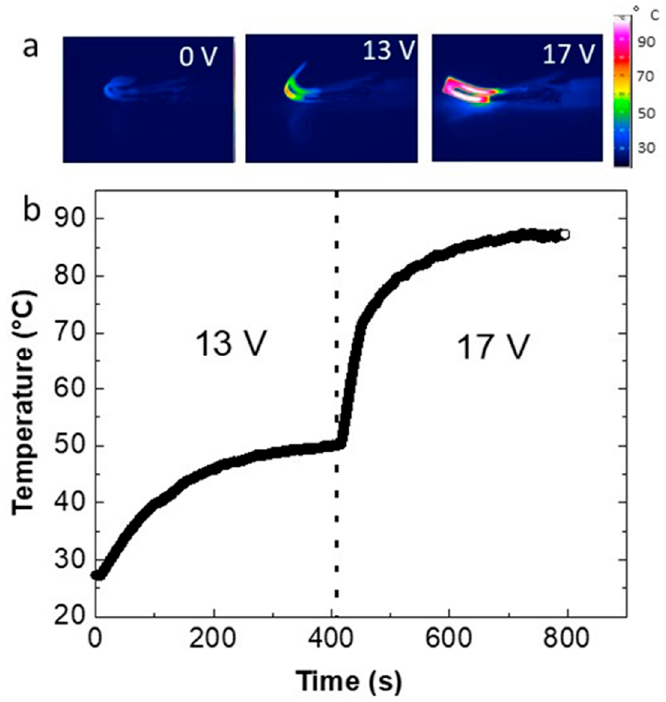
Figure 7. ( a ) IR thermographic images of the electrically triggered TSE of a “U” shaped composite part by a stepwise increase in voltage from 13 V to 17 V. ( b ) The temperature profile of the composite sample when subjected to two different voltages.